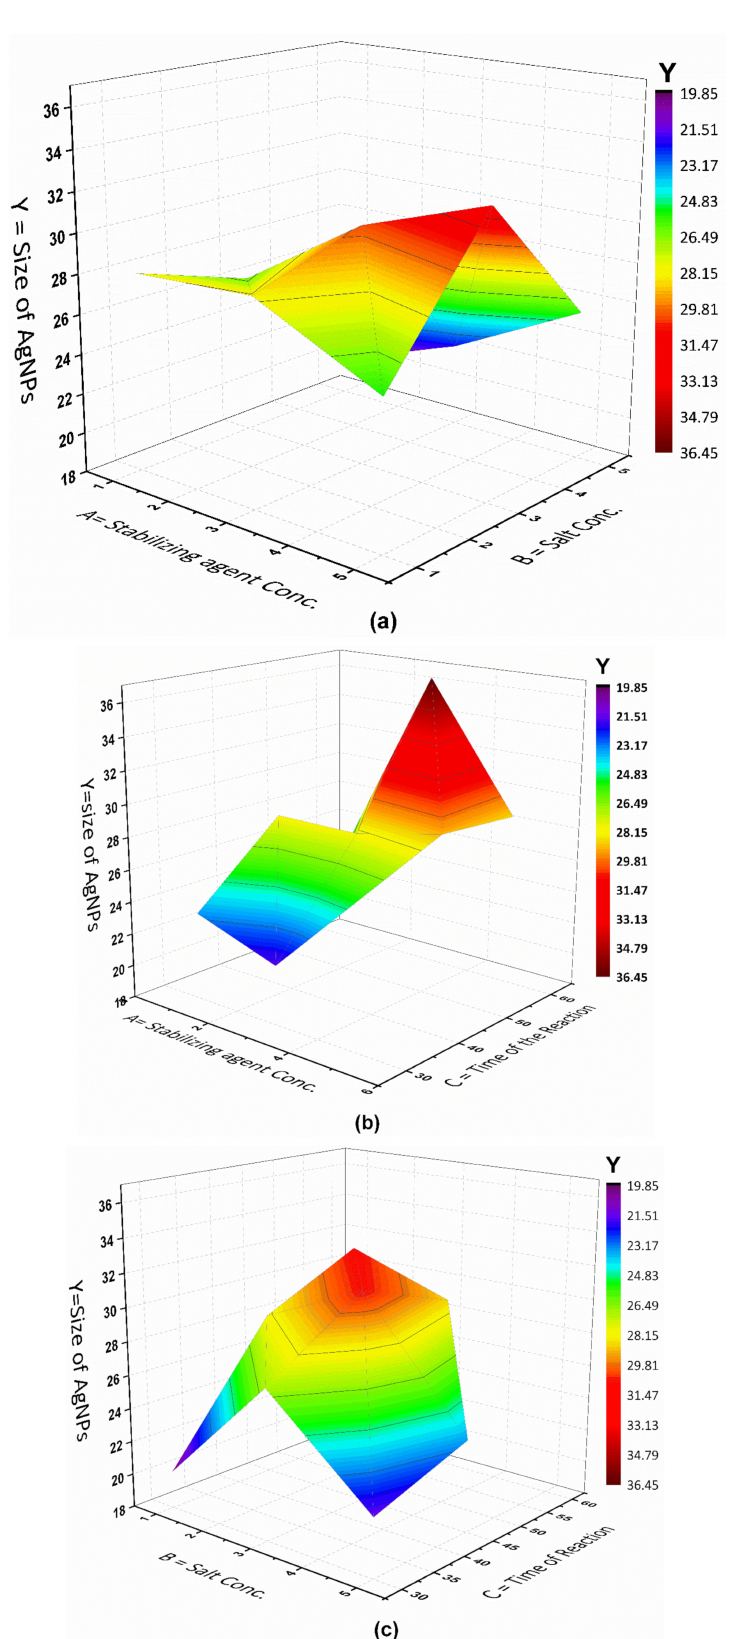
Figure 4. ( a – c ): 3D surface plot showing the effect of process parameters on the size of